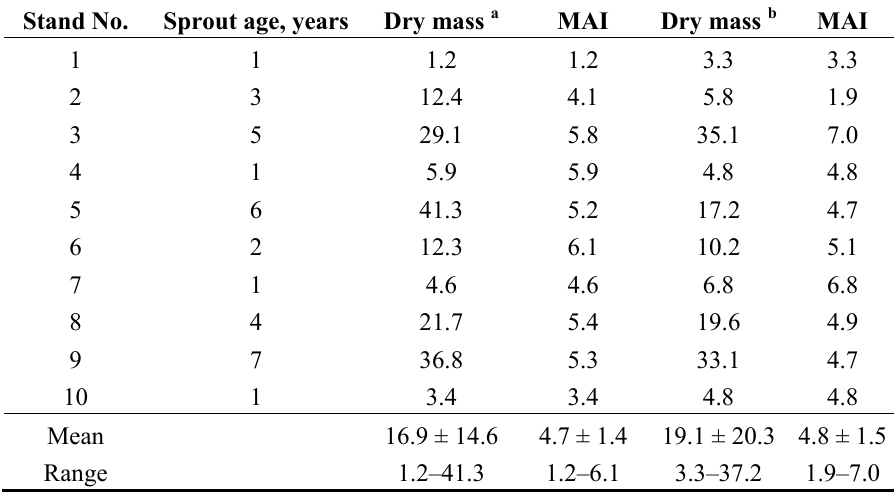
Table 7. Dry mass production of sprouts per living stump, tons ha − 1 . Stand No. Sprout age, years Dry mass a MAI Dry mass